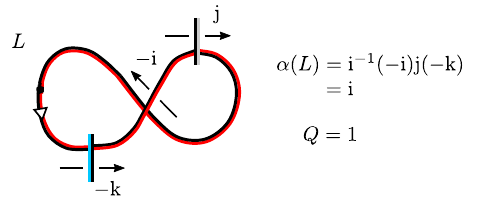
Fig. 6 De fi nition of the Q -invariant. The Q -invariant is computed using loops of a single color, the choice of which does not affect the result. The computation uses the α - invariants of loops. For a red loop L , α ( L ) is obtained by specifying a basepoint on L , traversing through the loop starting in the direction that has the black color of the bicoloring on the right, and multiplying all the elements of Q 8 obtained from undercrossings from right to left, after which a correction term i − ω is added. Above, ω is the self writhe of L , which is the signed count of the self crossings of L (Fig. 7). The α - invariant of a red loop is always a power of i, and if there exists only a single red loop L in the diagram, then the Q -invariant is de fi ned as exponent of α ( L ), which is well de fi ned modulo 4. In general, the Q -invariant is the exponent of ( − 1) l α ( L 1 ) ⋯ α ( L n ), where L 1 , … , L n are the red loops of the diagram, and l is the sum of the pairwise (modulo 2) linking numbers between red loops. It is veri fi ed in Methods that the Q -invariant is independent from the choices of color and the basepoints, and that it is conserved in topologically allowed strand crossings and